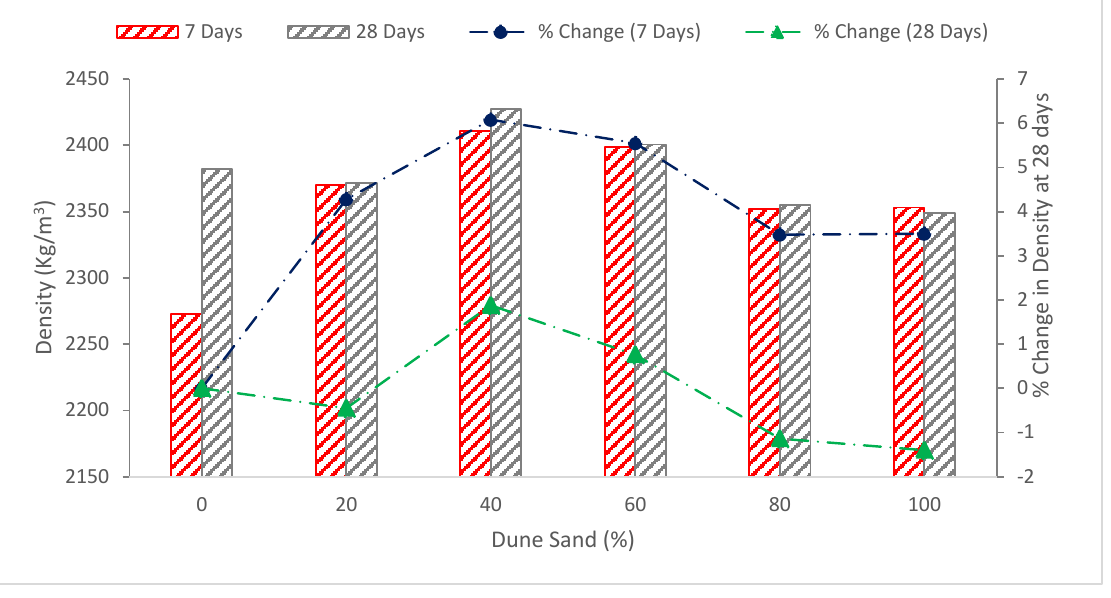
Figure 9. Dry density: data source [40].